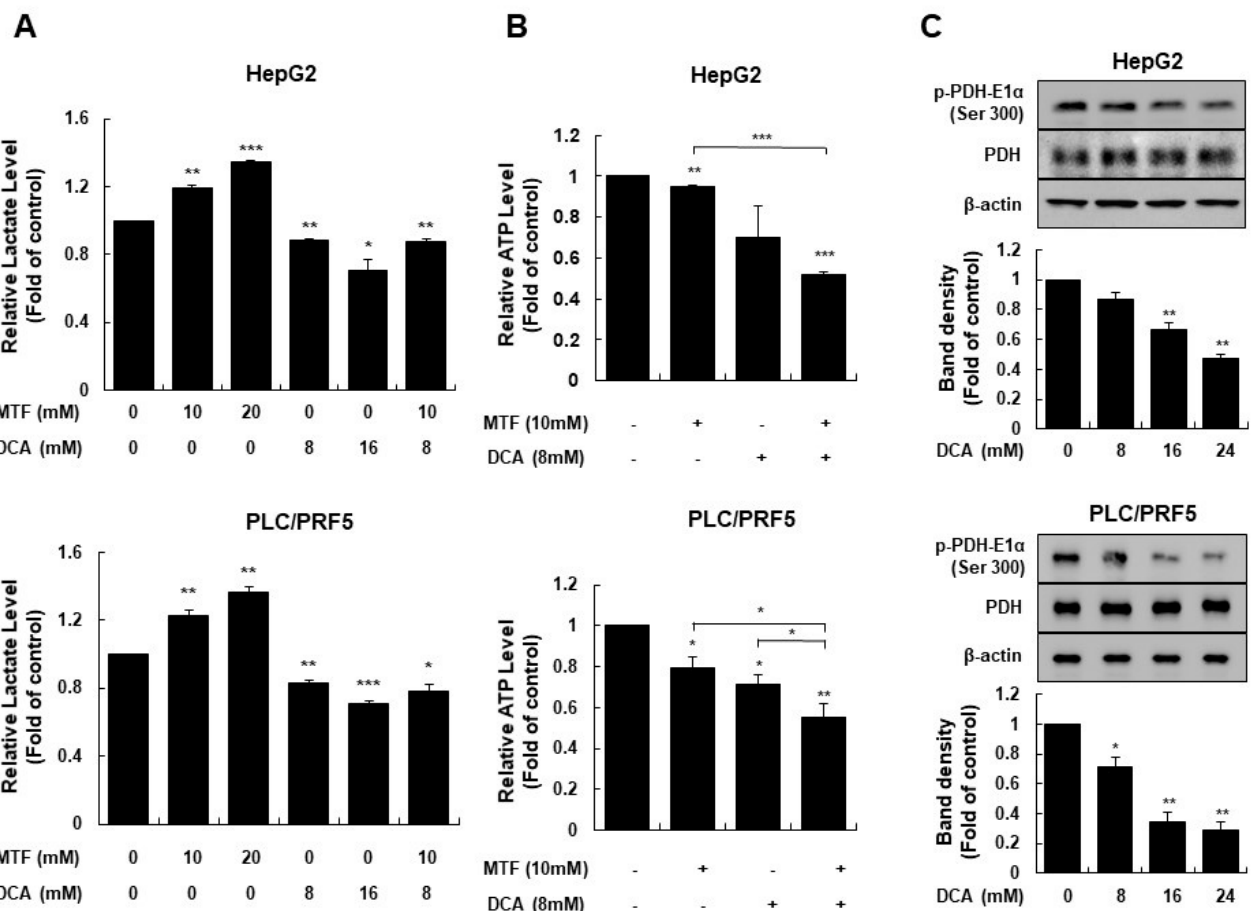
Figure 3. Metformin sensitized HepG2 and PLC/PRF5 cells to DCA by increasing glycolysis. Intracellular ATP production in liver cancer cells was suppressed by the metformin and DCA co-treatment. ( A ) Extracellular lactate levels increased significantly at higher metformin concentrations and decreased at higher DCA concentrations in liver cancer cells. The metformin and DCA co-treatment significantly suppressed lactate production compared to the control in liver cancer cells. ( B ) Intracellular ATP levels significantly decreased when liver cancer cells were treated with metformin or DCA, and co-treated with metformin and DCA, respectively. The metformin and DCA co-treatment significantly suppressed lactate production compared to the single treatment of metformin or DCA alone, and the control. ( C ) DCA significantly suppressed phosphorylation of the pyruvate dehydrogenase complex compared to the control in a dose-dependent manner. * p < 0.05; ** p < 0.01 and *** p <